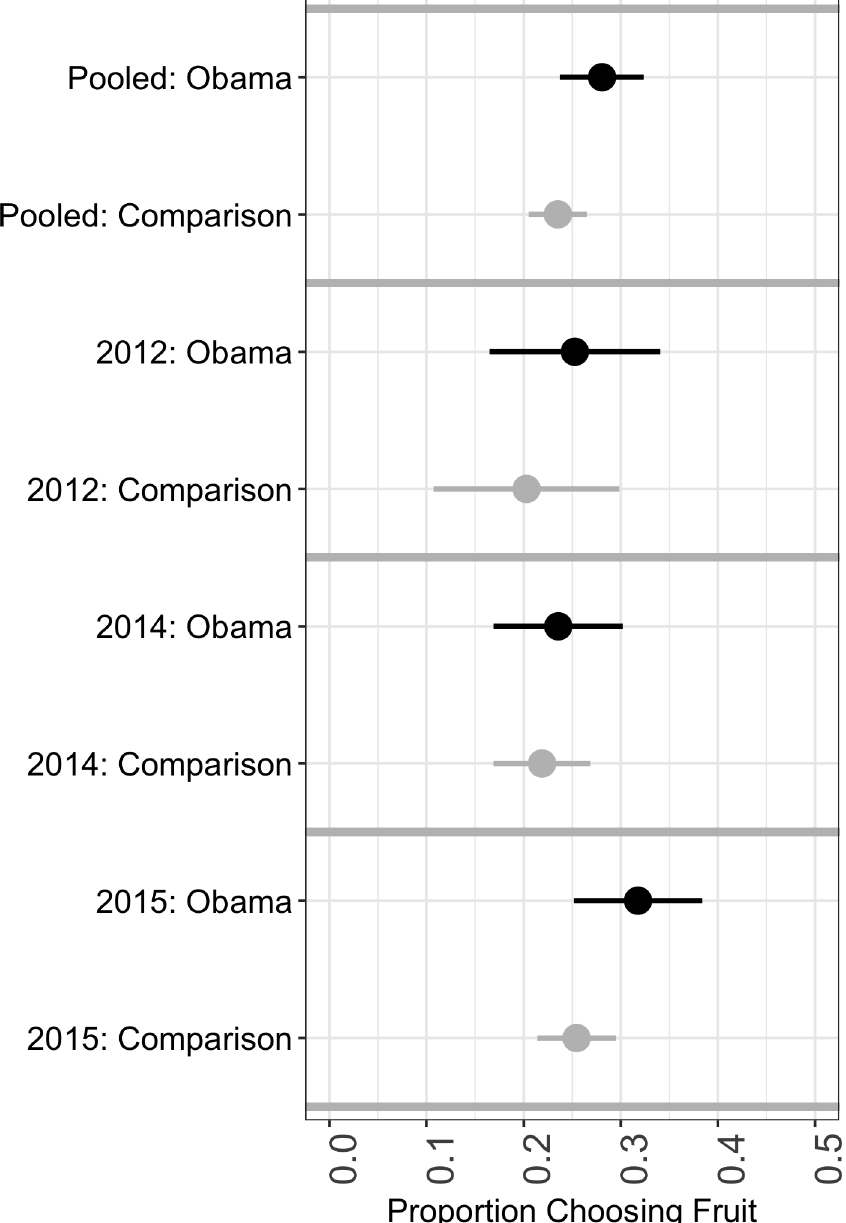
Fig 1. Estimatesof mean preferencesfor fruit over candy among trick-or-treaters, 95% confidence intervals.